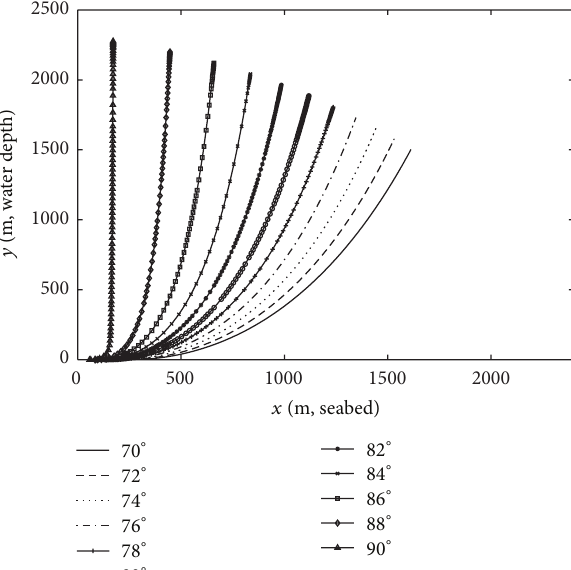
Figure 6: Configurations of the suspended pipeline in the second case.